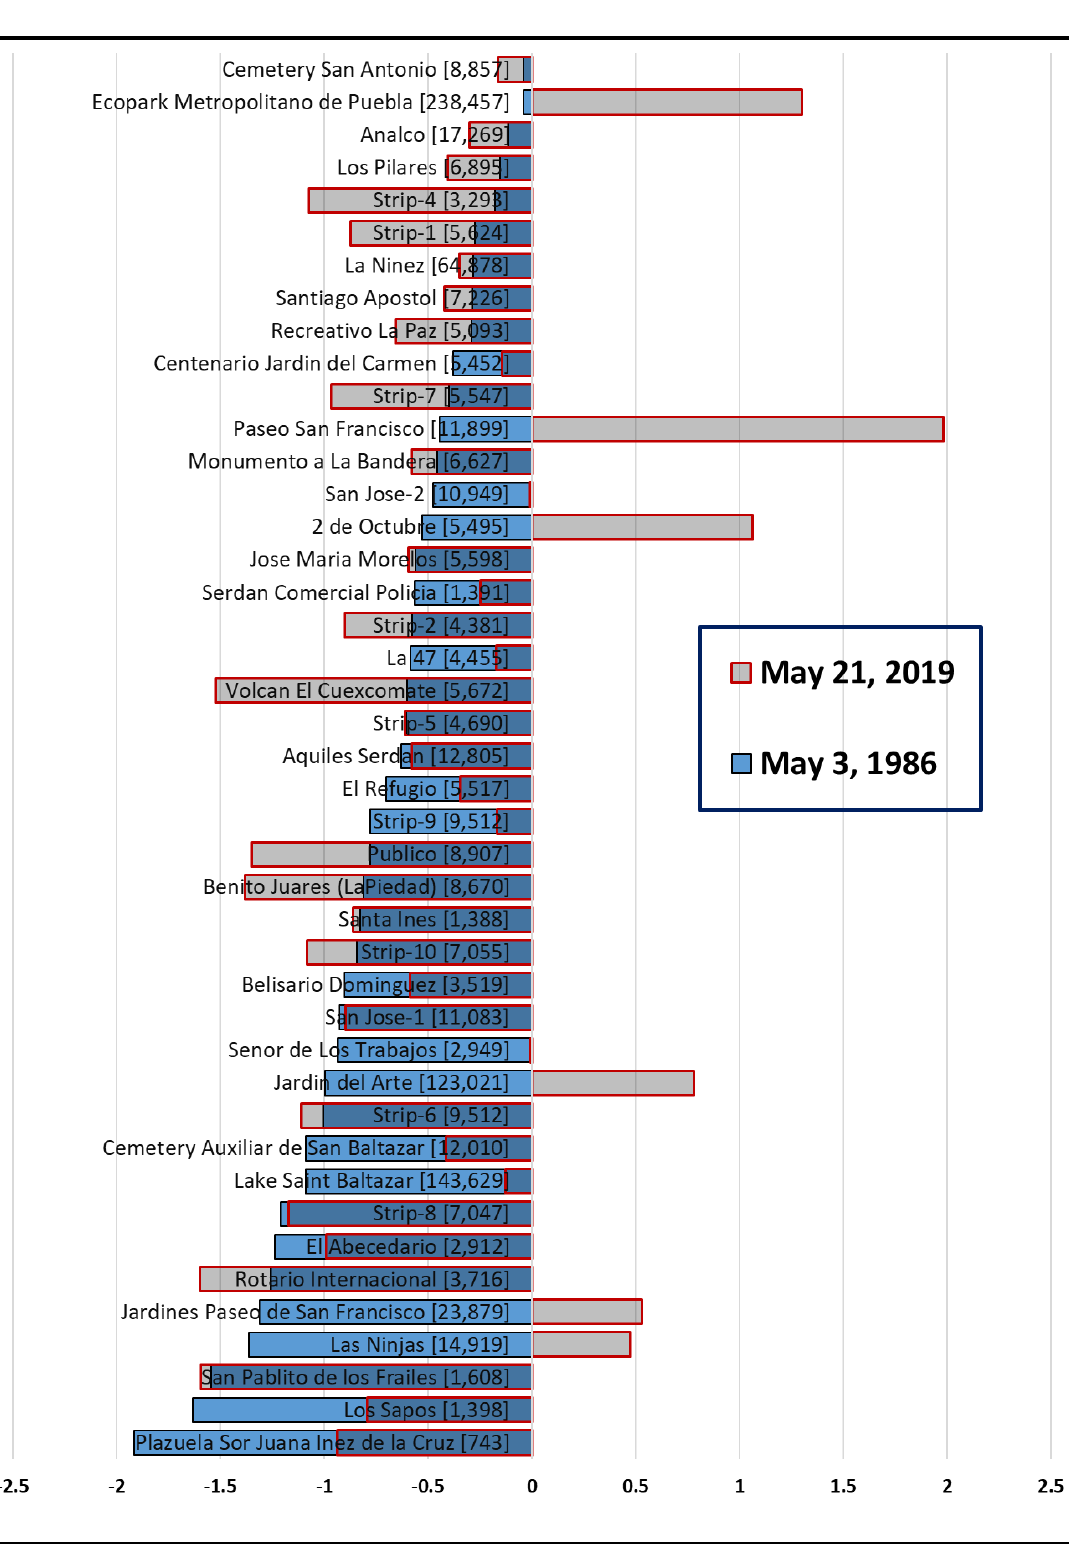
Figure 8. The results of 43 Urban green spaces (UGSs) with negative z-scores on 3 May 1986 compared with their z-scores on 21 May 2019. UGS size in m 2 is provided in [ ] behind the name of the UGS.